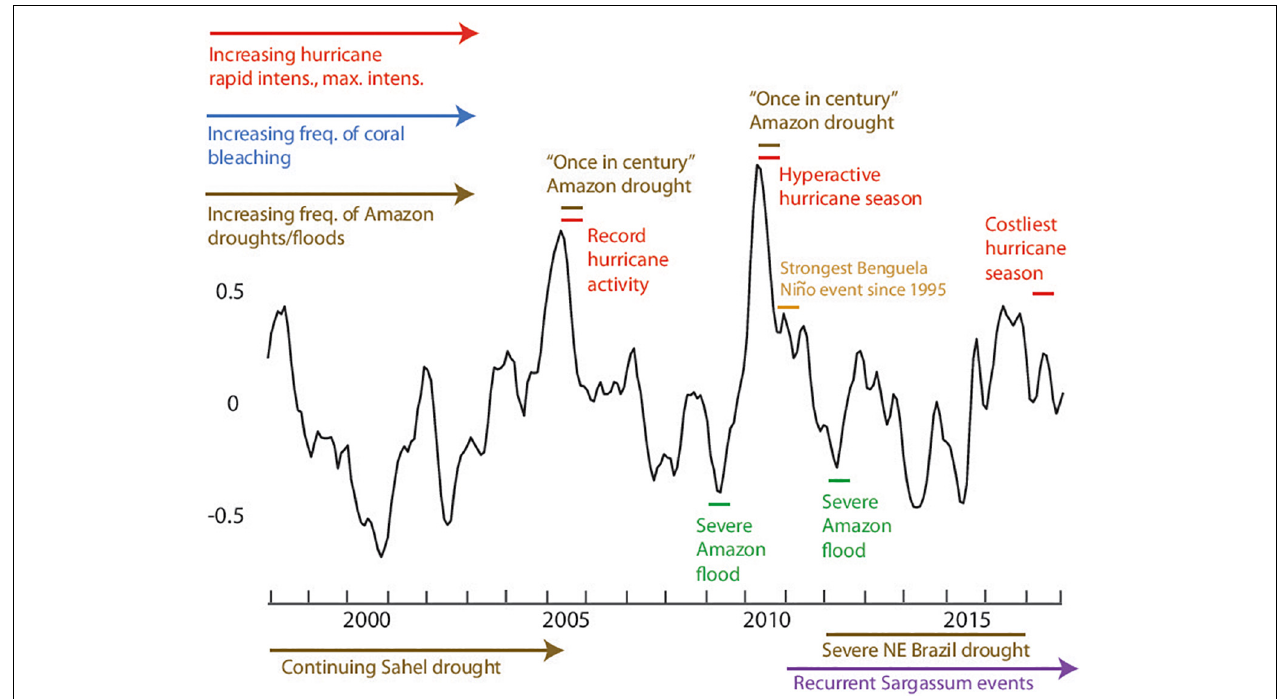
FIGURE 1 | Summary of notable tropical Atlantic societal impacts over the past 20 years. Black line is the monthly SST anomaly, relative to the 1998–2017 mean climatology, averaged between 5 ◦ N–25 ◦ N and 30 ◦ W–60 ◦